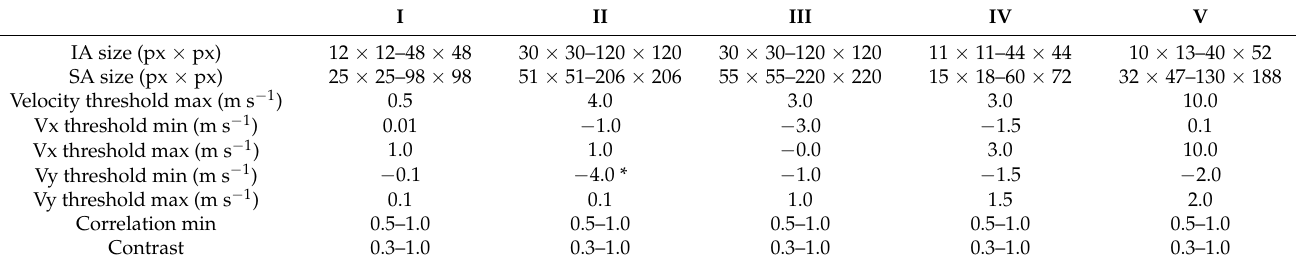
Table A2. Free-LSPIV parameters of case studies, (I) Kolubara River, (II) Murg River, (III) Salmon River, (IV) Loussios river at of Atsicholos Bridge, (V) Loussios river upstream of Atsicholos